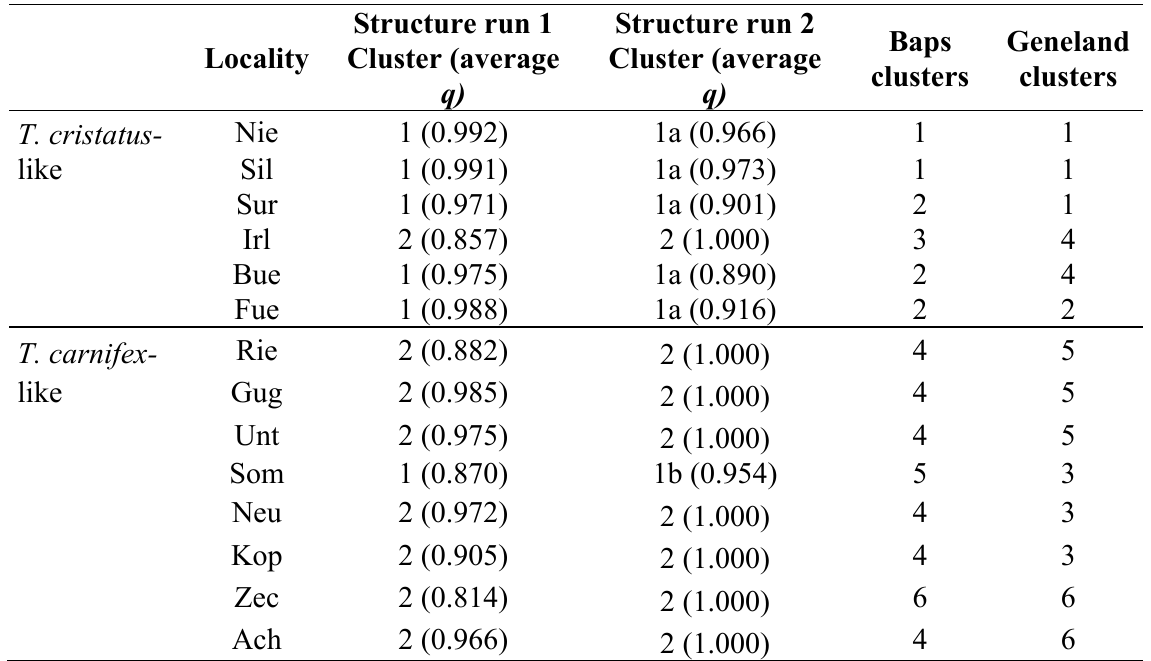
Table 4. Membership of surveyed populations to clusters assessed using three Bayesian methods; average q indicates the probability of populations being assigned to the clusters in structure